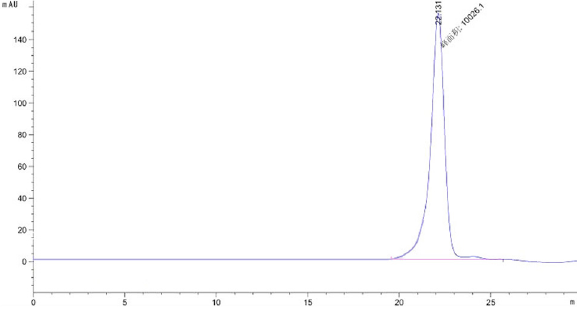
Figure 1: GB standard solution